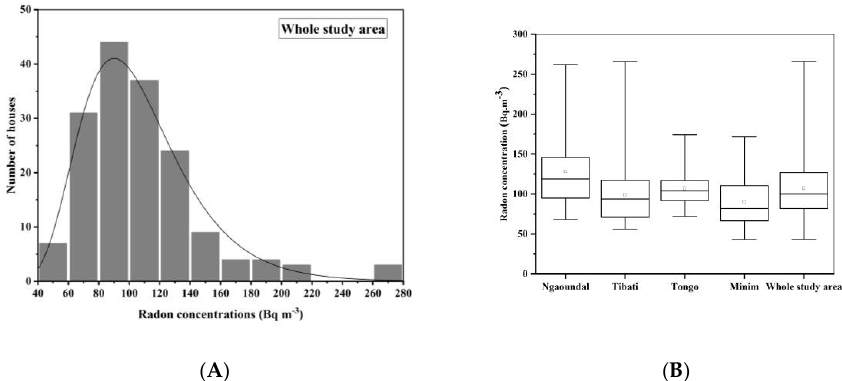
Figure 4. Lognormal distribution ( A ) of indoor 222 Rn in the bauxite-bearing Southern Adamawa. Boxplot distribution ( B ) is made for each study area and the whole bauxite-bearing areas. The total number of RADTRAK detectors analyzed was 169. Box plot refers to median, lower and upper quartiles. Outliers are shown on either side of the rectangular box at the limit of the vertical line. The small filled circle above the median represents the arithmetic mean.